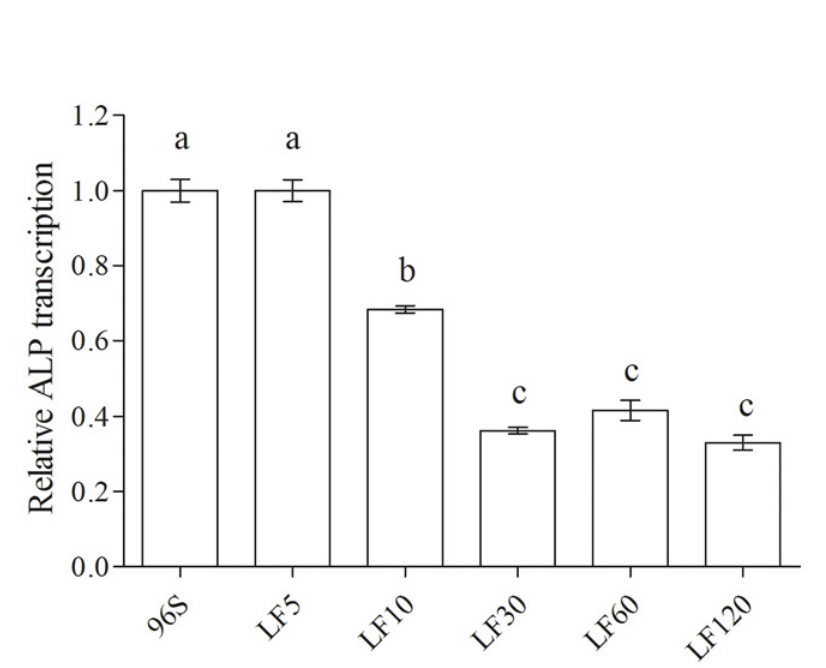
Fig 1. ALP activity in BBMV from susceptible and resistant H . armigera larvae. Different letters above the error bars indicate significant differences between means (P < 0.05).